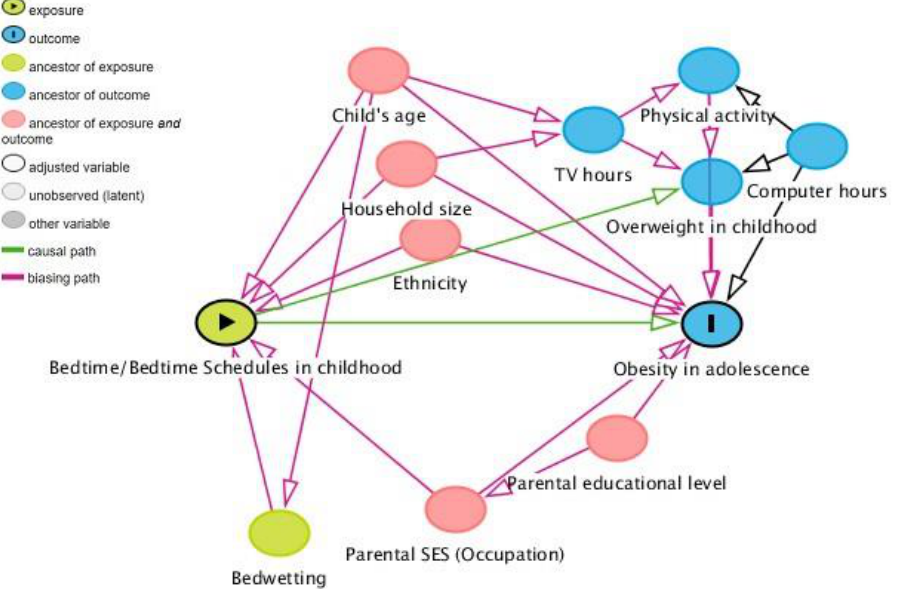
Figure 2. Directed acyclic graph (DAG) for the relationship between bedtime in childhood and obesity risk in adolescence showing all considered covariates. DAG legend is shown on the top left-hand corner.